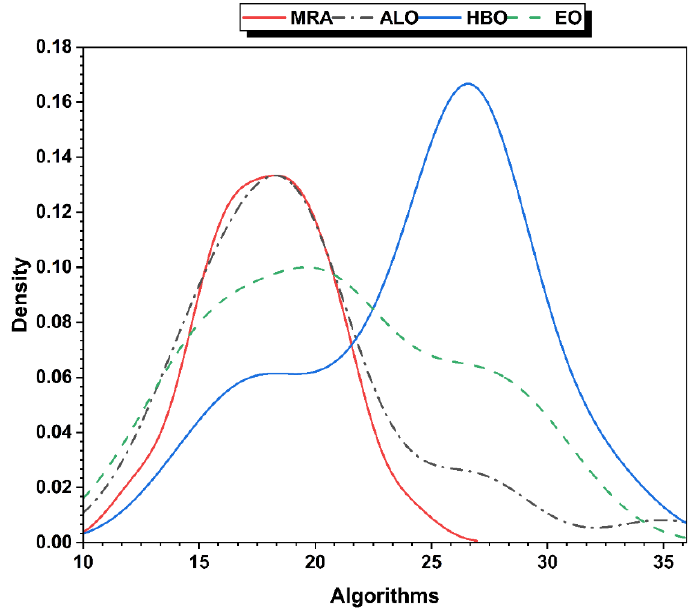
Figure 4. FS distributions of selected algorithms.